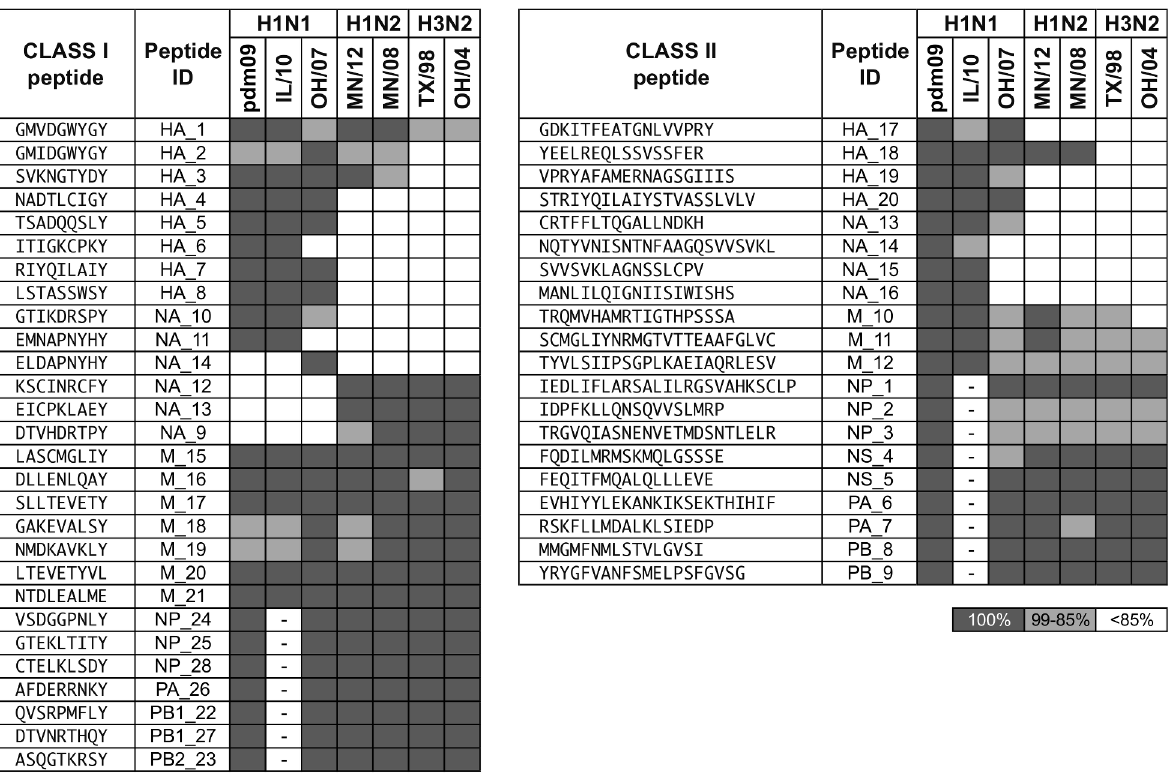
Fig 3. Class I and II predicted peptides. Peptides were selected based on predicted binding to class I and class II SLA alleles and conservation in IAV strains. The identity percentage between peptides and IAV strains is shown (100% dark gray, 99% - 85% gray, and < 85% white). The Peptide ID is coded to the source protein. Sequences not available are marked with -.